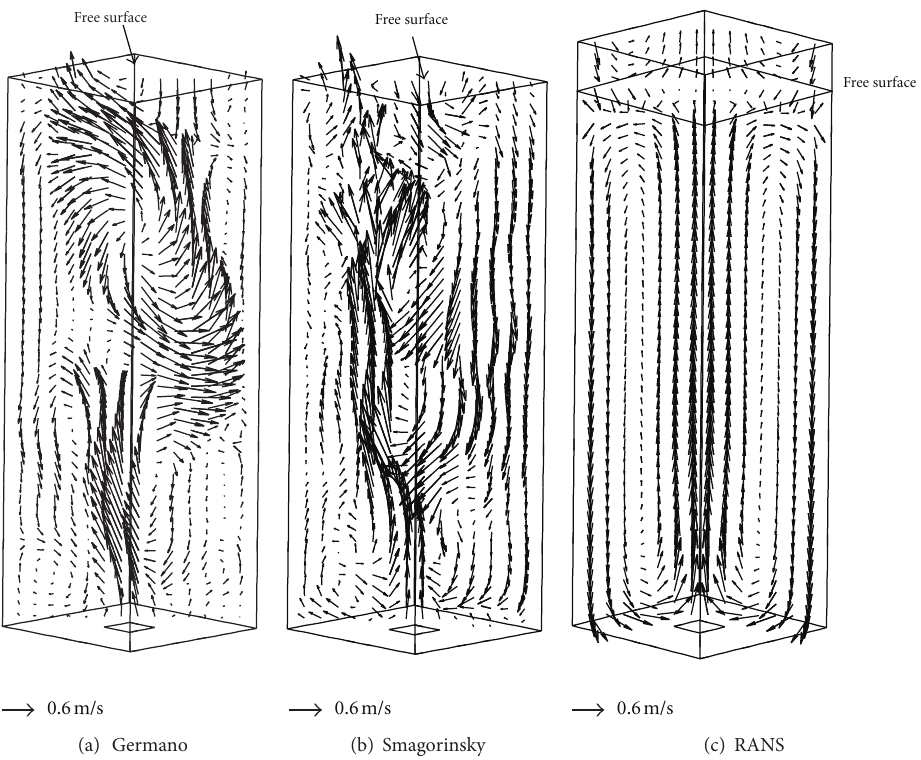
Figure 7: Predicted instantaneous vector flow field for axial liquid velocity after 150s, for all three models (from Dhotre et al. [20]).